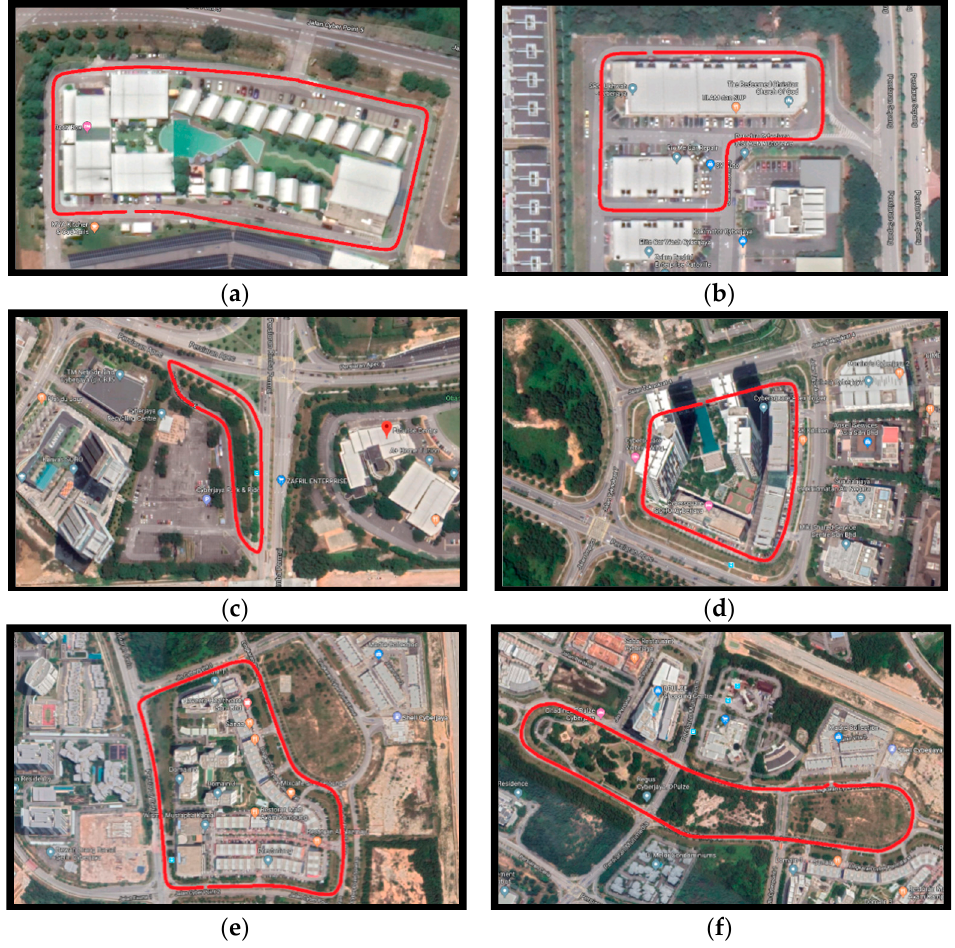
Figure 9. Ariel views of test locations: ( a ) Map 1, ( b ) map 2, ( c ) map 3, ( d ) map 4, ( e ) map 5, and ( f ) map 6.